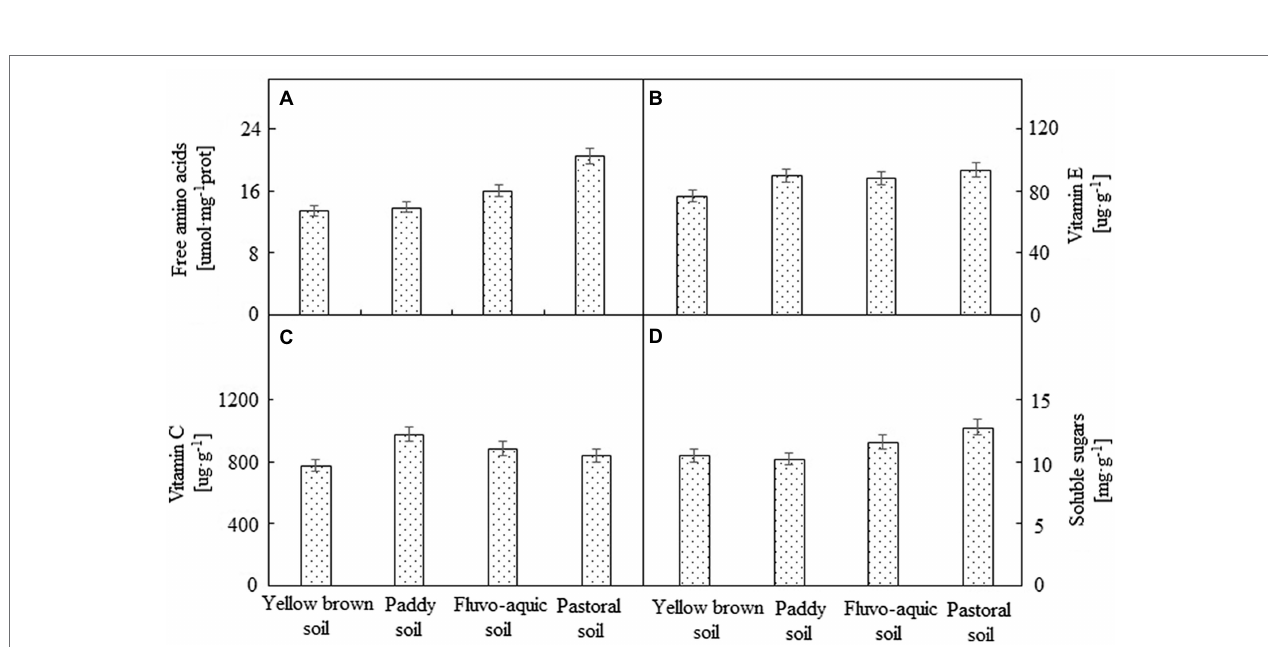
FIGURE 2 | The nutrient composition of pepper grown in different soils. (A–D) represented Free amino acid, vitamin E,vitamin C and soluble sugars, respectively.